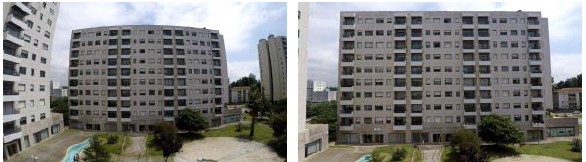
Figure 2. Video frame in wide mode (left) and linear mode (right)